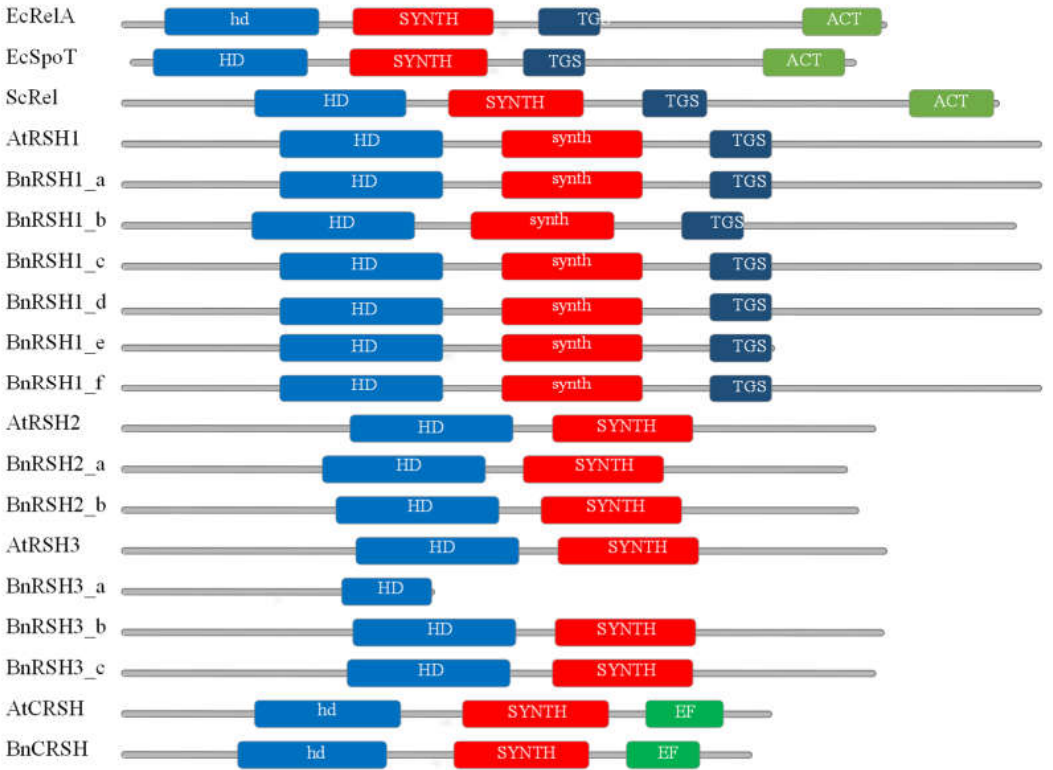
Figure 3. Predicted primary structures of RSH1, RSH2/RSH3, and CRSH proteins from A. thaliana and B. napus . HD (hd contains HD-SE substitution) (p)ppGpp hydrolase domain; SYNTH (synth contains G-S substitution) (p)ppGpp synthase domain; ACT aspartate kinase chorismate mutase TyrA domain; EF Ca 2+ -binding domain; TGS: threonyl-tRNA synthetase, GTPase, SpoT domain.